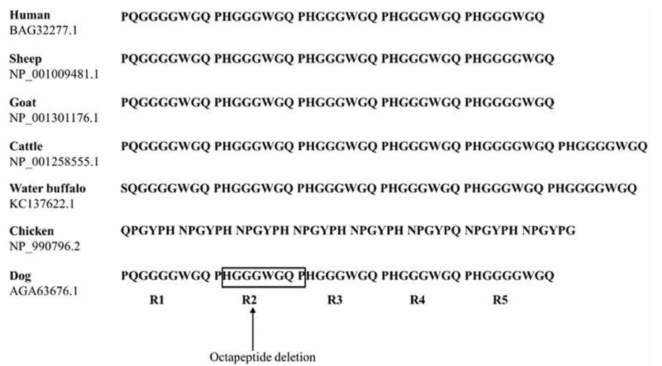
Figure 4. Comparison of tandem repeat sequences in humans, sheep, water bu ff alos, goats, cattle, chickens, and dogs. Octapeptide repeat sequences were obtained from GenBank at the National Center for Biotechnology Information (NCBI), including human ( Homo sapiens , BAG32277.1), sheep ( Ovis aries , NP_001009481.1), goat ( Capra hircus , NP_001301176.1), cattle ( Bos taurus , NP_001258555.1), water bu ff alo ( Bubalus bubalis , KC137622.1), chicken ( Gallus gallus , NP_990796.2), and dog ( Canis lupus familiaris , AGA63676.1). The arrow indicates the octapeptide repeat deletion polymorphism found in this